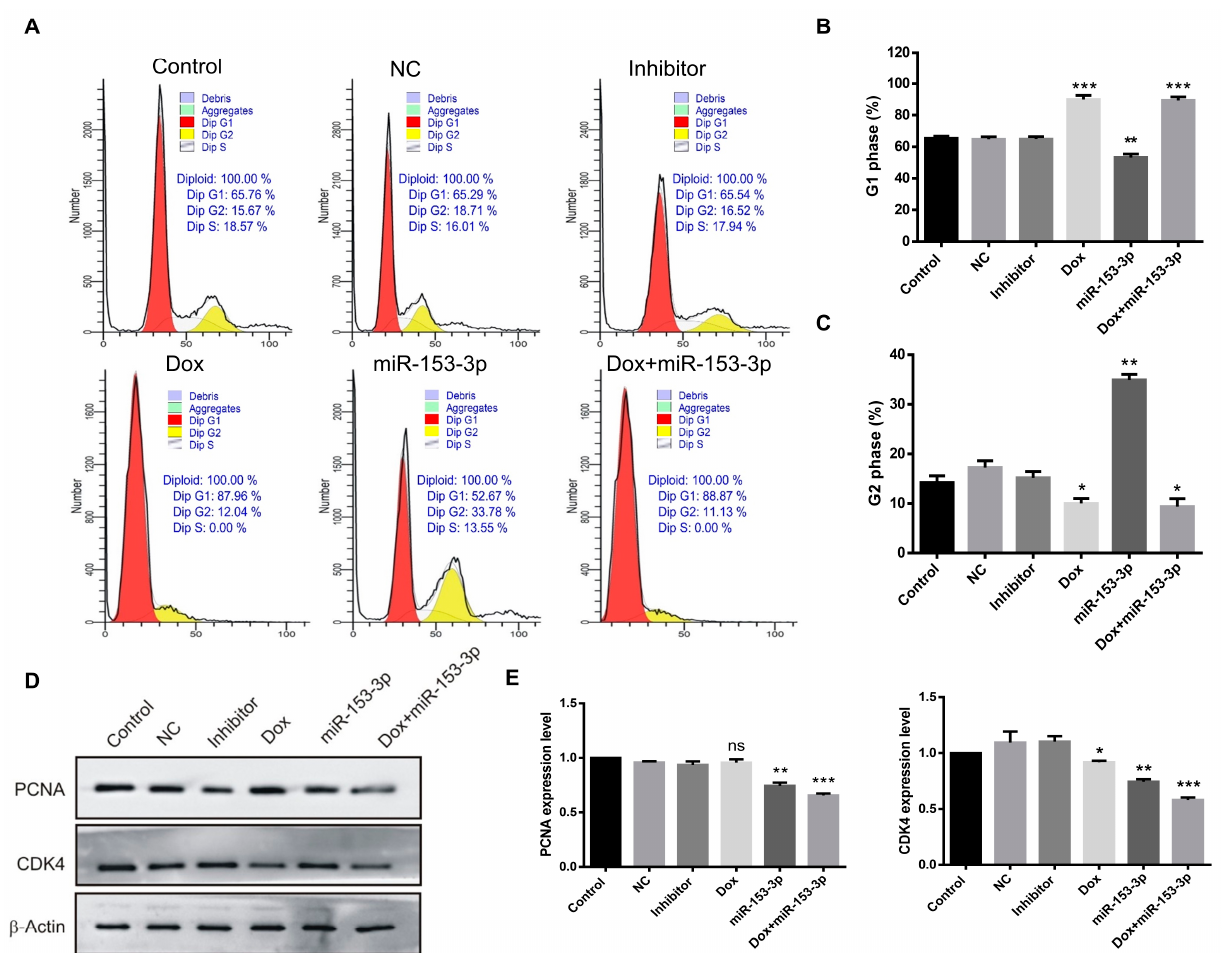
Figure 9. Effects of miR-153-3p, Dox, and miR-153-3p+Dox treatment on the cell cycle in MDA-MB- 231 cells. ( A ) Cell cycle phase distribution by flow cytometry. ( B , C ) Quantification of the G1 and G2 phases. ( D , E ) Proteins analysis of CDK4 and Cyclin D1 (ns: not significant; * p < 0.05; ** p < 0.01; *** p < 0.001, original blot see Supplementary File S1).